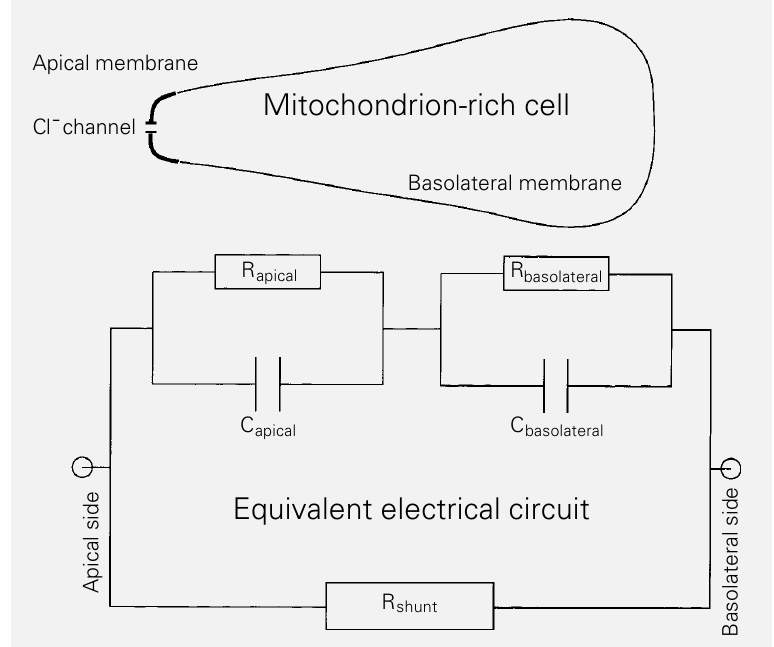
Figure 1 - Mitochondrion-rich cell and its equivalent electrical circuit. Top , Schematic representation of a mitochondrion-rich cell (MR-cell) of the epithelium, indicating the locations of the apical and basolateral membranes and of apical voltage-dependent Cl - channels. Bottom , Equivalent electrical circuit of the MR-cell compartment. The voltage-dependent Cl - channels are located on the apical membrane. Elec- tromotive forces were taken out for simplification. R apical and R basolateral are the apical and basolateral resistances, respectively. C apical and C basolateral are the apical and basolateral capacitances, respectively. R shunt is the resistance of the shunt-pathway which in our case essentially includes the paracellular space and the principal cell